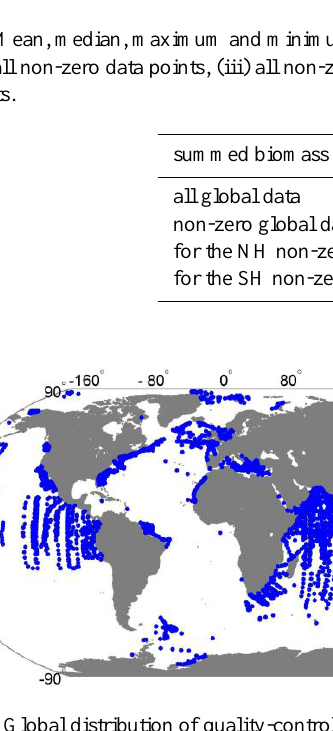
Figure 4: Global distribution of quality-controlled pteropod data . 987